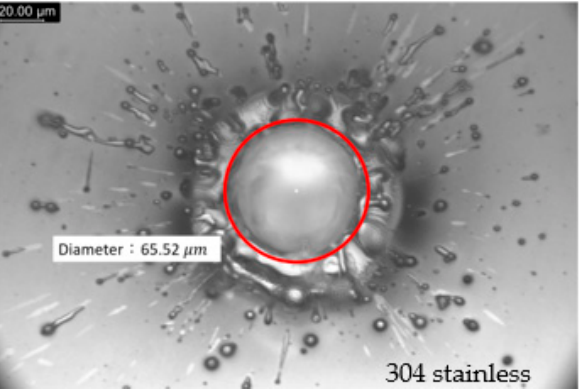
Figure 3. Diameter measurement using a microscopy (with laser drilling parameters of 0.5 mJ laser pulse energy and 12 laser pulse shots).